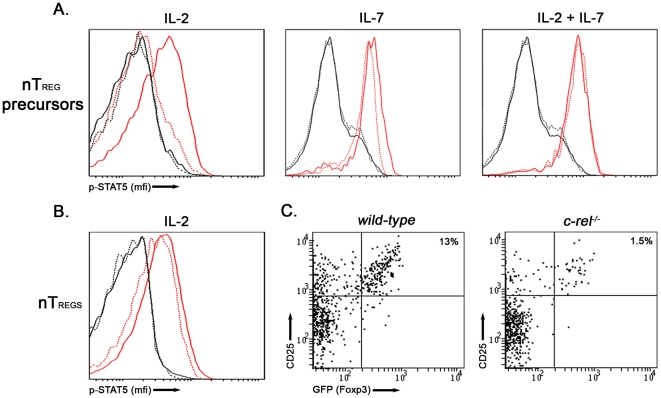
The IL-2 induced phosphorylation of STAT5 is impaired in c-rel−/− nTreg precursors.Purified nTreg precursors and nTregs isolated from foxp3gfp and c-rel−/−foxp3gfp mice stimulated with IL-2, IL-7 or IL-2 plus IL-7 for 30 minutes, were fixed, permeabilized and stained with antibodies to phospho-STAT5. (A) Phospho-STAT5 levels in cytokine stimulated wt and c-rel−/− nTreg precursors (CD25+Foxp3−CD4SP thymocytes). Histograms show expression levels (mfi) of phospho-STAT5 in wt (solid line) and c-rel−/− (broken line) nTreg precursors without (black lines) or in response to cytokine stimulation (red lines). (B) Phospho-STAT5 levels in IL-2 stimulated wt and c-rel−/− nTregs (CD25+Foxp3+CD4SP thymocytes). (C) Percentages of CD25hiFoxp3+ cells developing in cultures of wt and c-rel−/− nTreg precursors (CD25+Foxp3−CD4SP cells) co-stimulated with IL-2 plus IL-7. Experiments were performed as described in Fig. 3. The data shown in A and B are representative of three independent experiments, using 3 mice of either genotype in each experiment, while the data shown in panel C is based on three independent experiments.